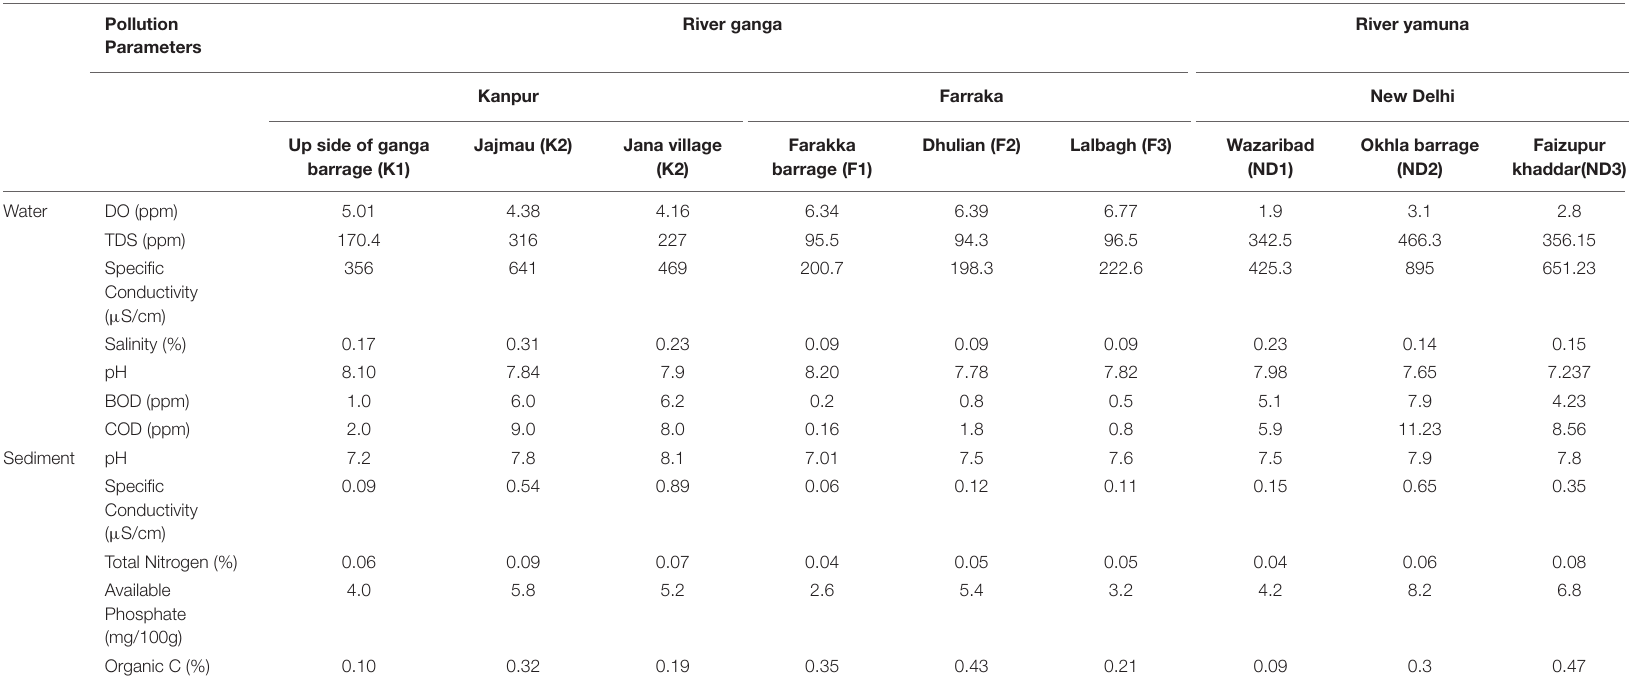
TABLE 2 | Physiochemical parameters of water and sediment at different sampling sites of river Ganga and Yamuna. Pollution